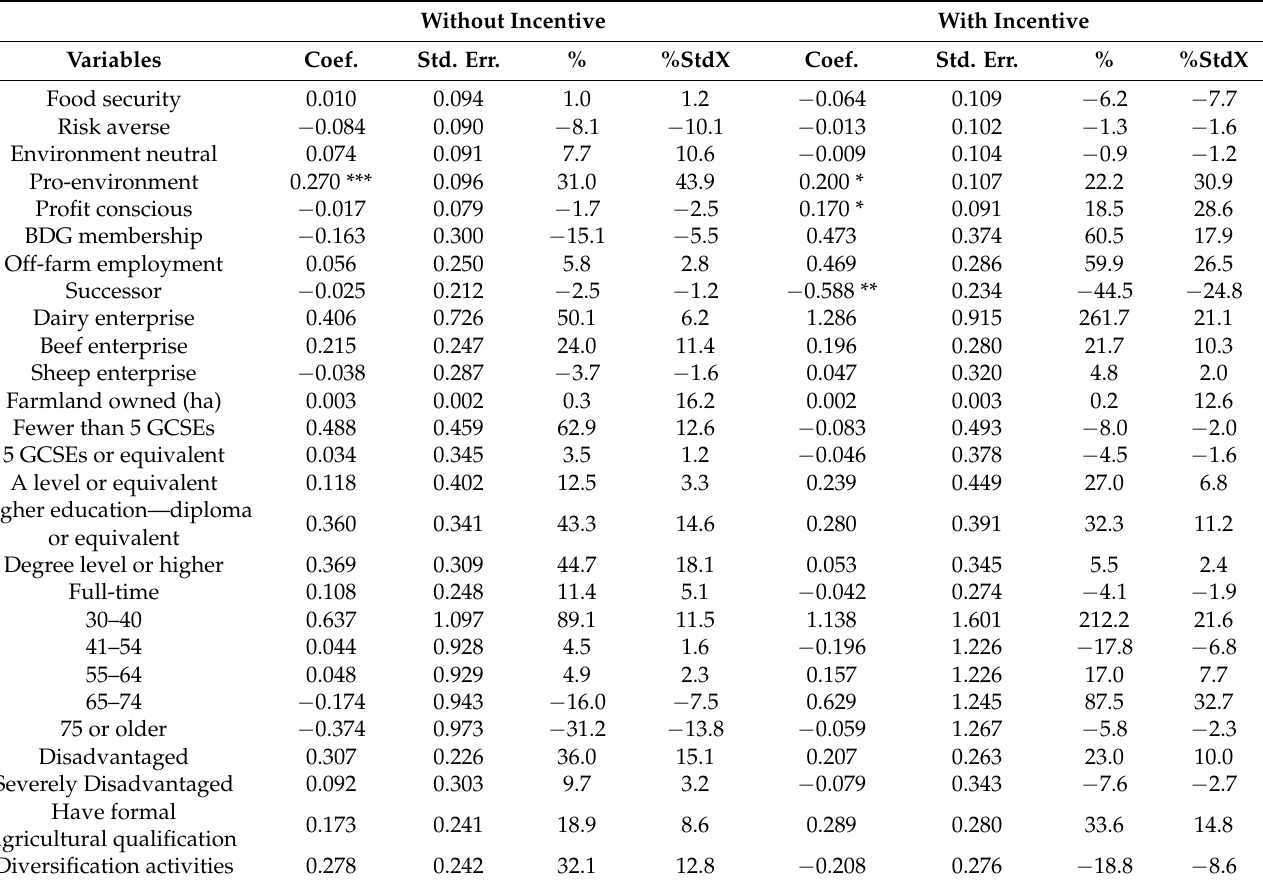
Table 5. Estimates of determinants of intention to adopt long-term land leasing for lessors (N = 397). Without Incentive With